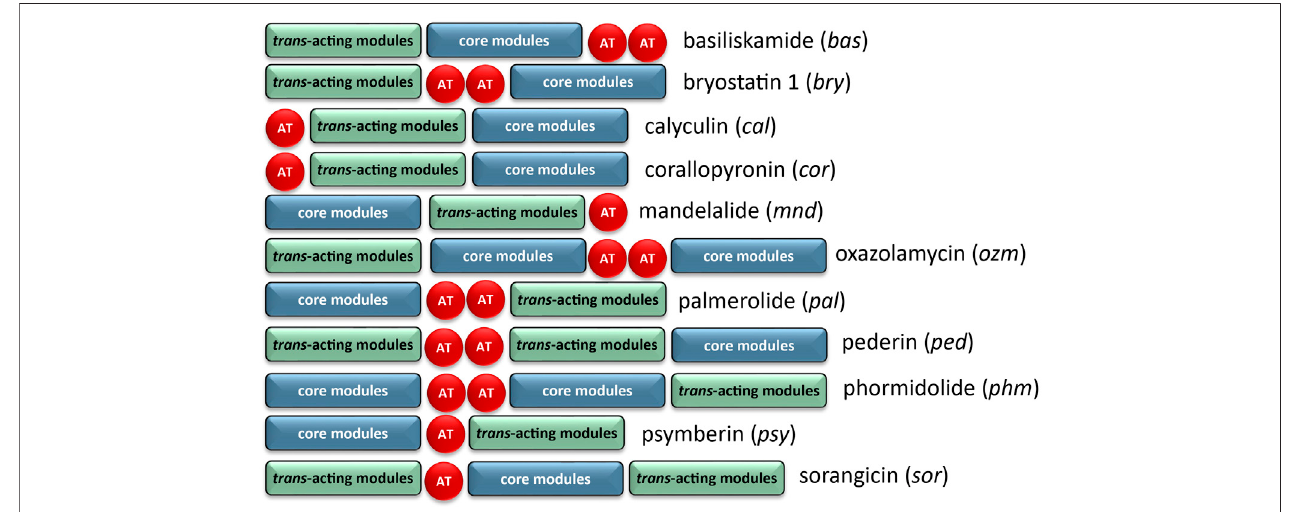
FIGURE2| Comparison ofBGCorganizationofselect trans -ATsystems.There issigni fi cantvariabilityintheorderofthecoremodules,ATmodules,and modules which contain trans -acting tailoring enzymes. There is also variability in the number of encoded AT modules, though the AT modules are typically encoded on separate, but tandem genes if more than one is